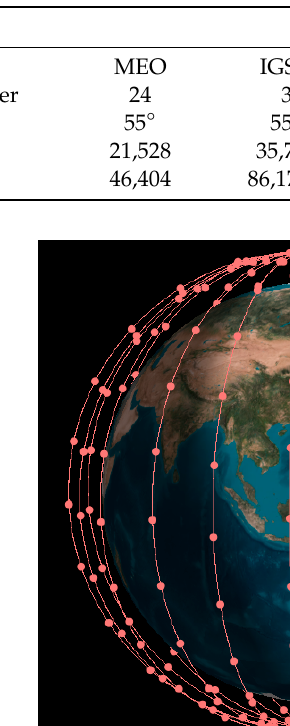
Figure 9. The ratio of positioning precision between the longitude component and the component latitude for BDS-3. Table 8. Parameters of the BDS-3 + low earth orbit (LEO) + HEO constellation.